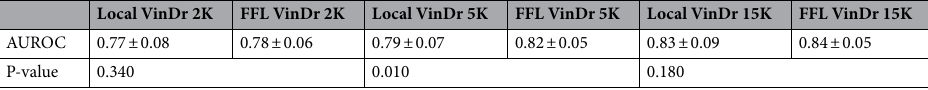
Table 2. Results of the comparison between local and FFL-based training of VinDr-CXR dataset with overlapping labels for different training set sizes, tested on the VinDr-CXR benchmark. Average AUROC values over no finding , aortic enlargement , pleural thickening , cardiomegaly , pleural effusion , pneumothorax , and atelectasis . The FFL was performed in combination with UKA-CXR dataset of n = 122,294 images with 7 other labels including cardiomegaly , pleural effusion right , pleural effusion left , pneumonic infiltrates right , pneumonic infiltrates left , atelectasis right , and atelectasis left.